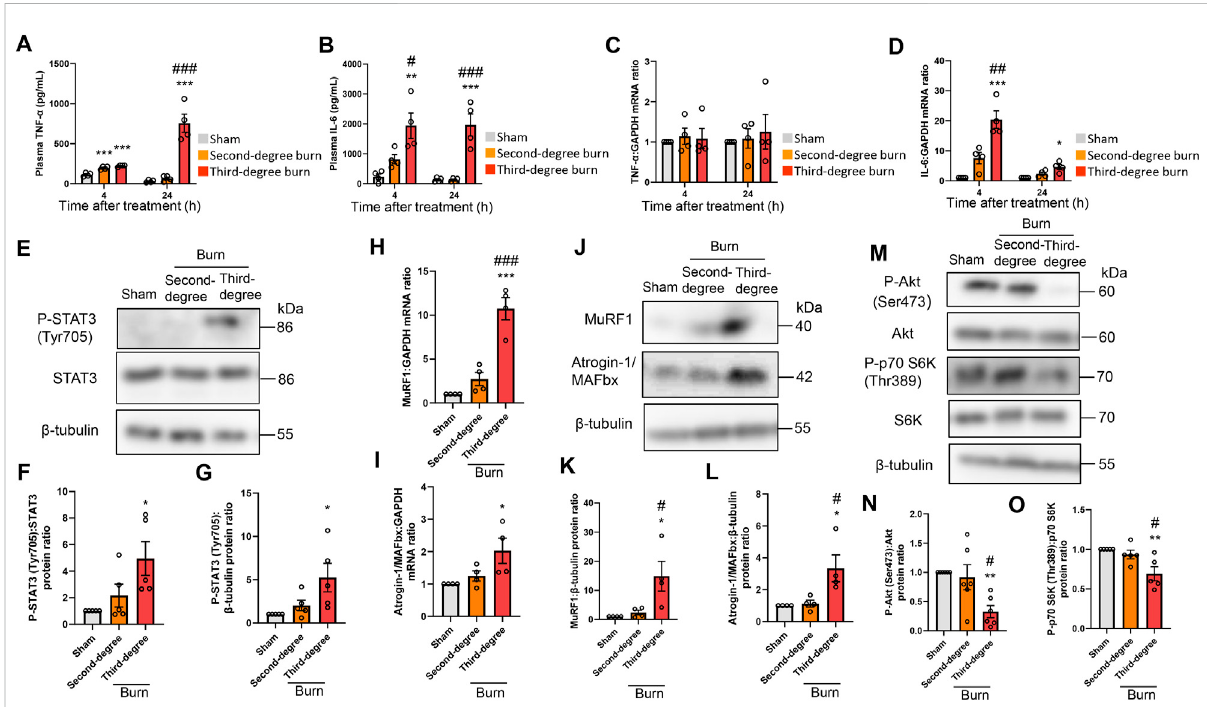
FIGURE 2 Thermal burn injury activates STAT3 and muscle proteolytic pathways, and reduces muscle anabolic pathways in mice by a severity dependent mechanism. Second-degree, third-degree, or sham burns were administered to wild-type C57BL/6 mice (12 – 16-week-old male mice) and 4 and 24 h after burn or sham-burn injury, plasma samples were prepared and TNF- α (A) and IL-6 (B) concentrations were measured by ELISA. N = 4/ group. qRT-PCR analysis of TNF- α (C) and IL-6 (D) mRNAs in TA muscles 4 and 24 h after burn or sham-burn injury. Data were normalized to GAPDH mRNA levels and are shown as fold increase over the sham controls. N = 4/group. Western blot analysis (E) and quanti fi cation of P-STAT3 (F,G) in TA muscles 24 h after burn or sham-burn. Data were normalized to STAT3 protein levels (F) or β -tubulin protein levels (G) and the ratio in sham-controlmicewassetas1.N=5/group.qRT-PCRanalysisofMuRF1 (H) andAtrogin-1/MAFbx (I) mRNAsinTAmuscles24 hafterburnorsham- burninjury.DatawerenormalizedtoGAPDHmRNAlevelsandareshownasfoldincreaseovertheshamcontrols. N=4/group.Westernblotanalysis (J) and quanti fi cation of MuRF1 (K) and Atrogin-1/MAFbx (L) expressions in TA muscles 24 h after burn or sham-burn treatment. Data were normalized to β -tubulin protein levels and the ratio in sham-control mice was set as 1. N = 4/group. Western blot analysis (M) and quanti fi cation of P-Akt (N) and P-p70 S6K (O) expressions in TA muscles 24 h after burn or sham-burn treatment. Data were normalized to Akt and p70 S6K protein levels, respectively, and the ratio in sham-control mice was set as 1. N = 5 – 6/group. For all panels, data are presented as the mean ± s.e.m. *** p